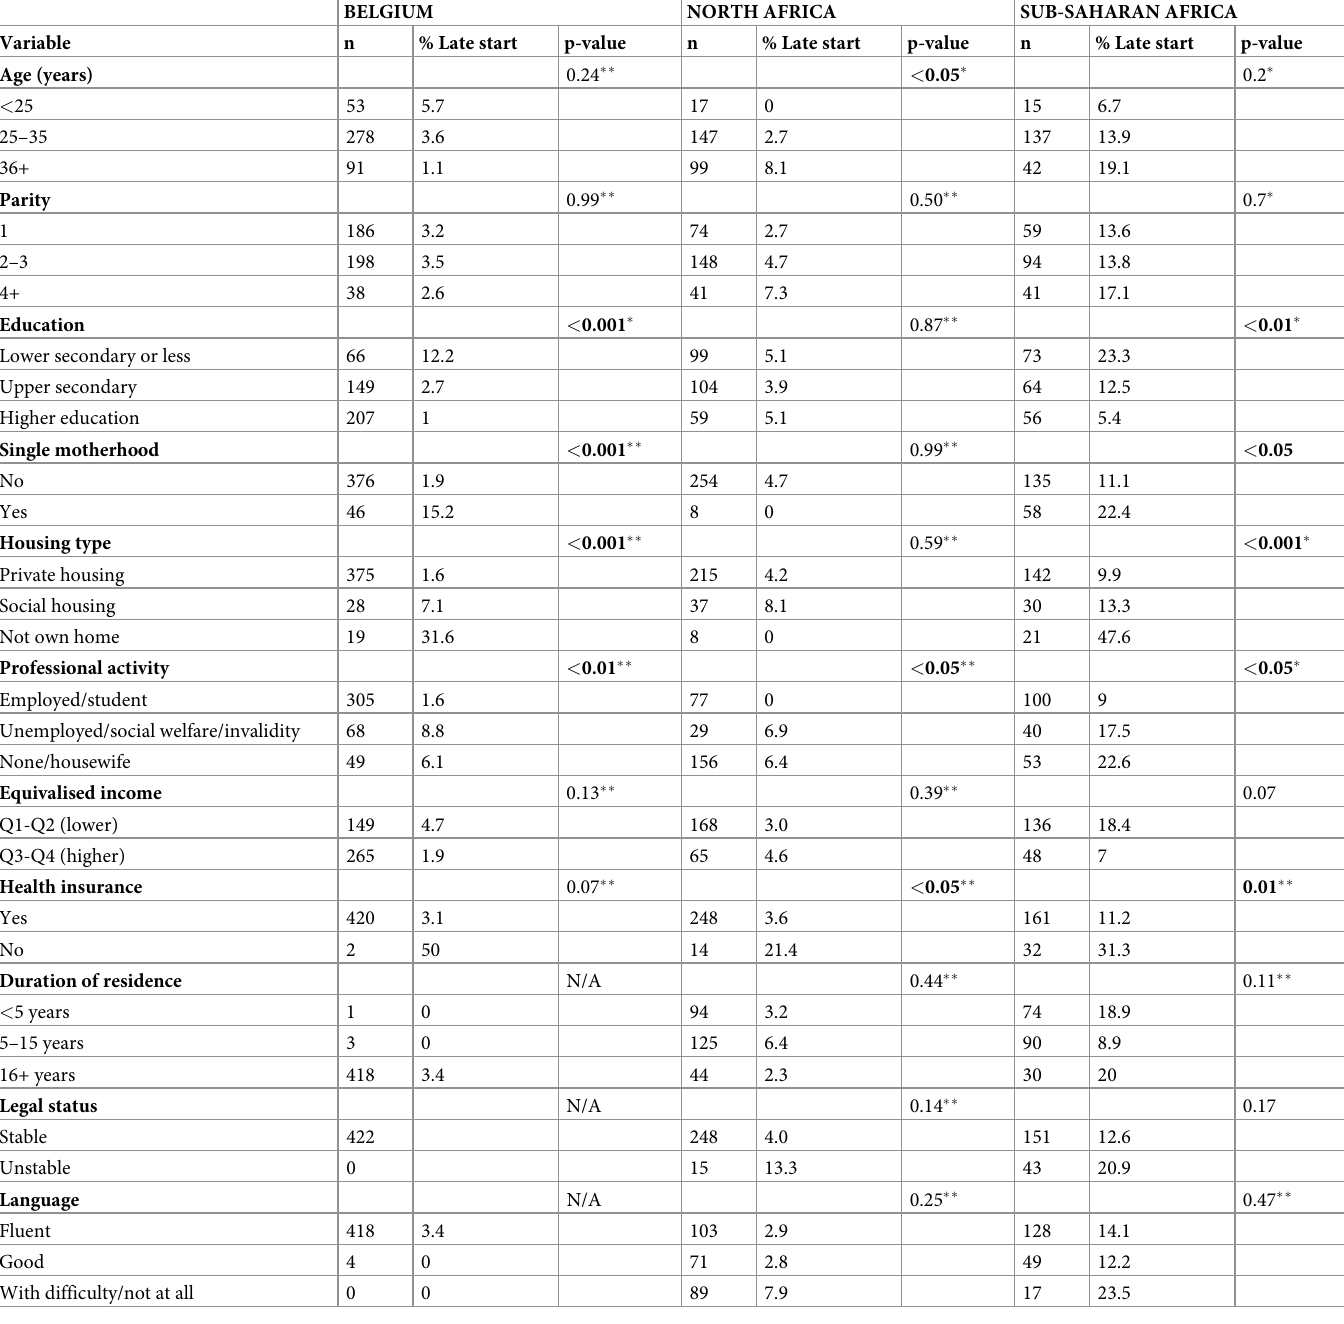
Table 4. Predictors of late start of antenatal care by region of birth, with Chi 2 or Fisher exact p-values.